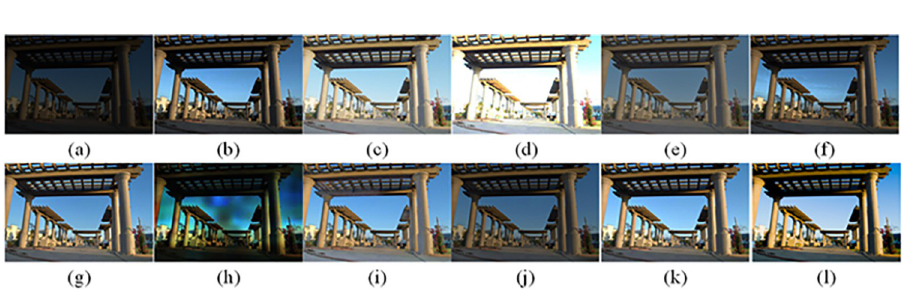
Fig 14. Comparisons of the ten algorithms in enhancing low-light image 4. (a) low-light image (b) AGCWD (c) Al- Ameen (d) BHE2PL (e) BIMEF (f) BPDHE (g) LIME (h) MSRCR (i) NPEA (j) SRIE (k) OURS (l) Normal light image.